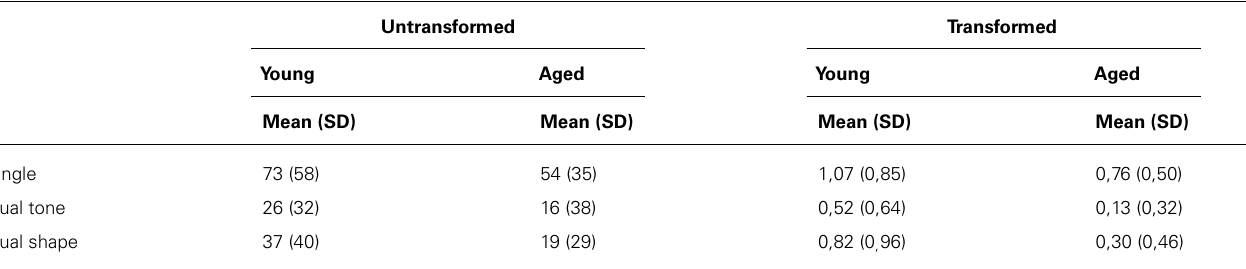
Table 1 | Sequence learning effects (random Block 11 subtracted from the mean of sequenced Blocks 10 and 12) in single, dual tone, and dual shape conditions for young and aged adults, derived from z-score transformed and untransformed